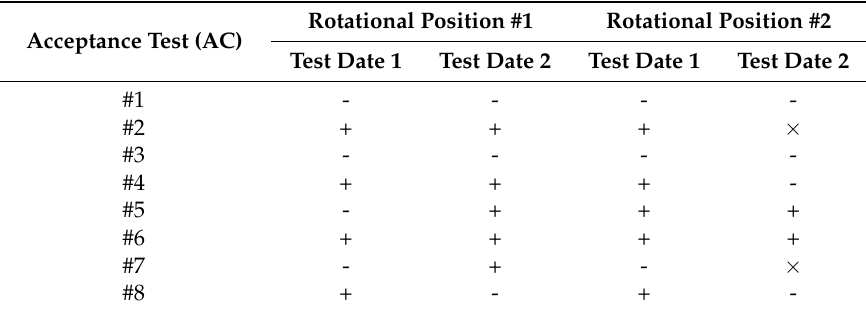
Table 5. Summary of Acceptance Test